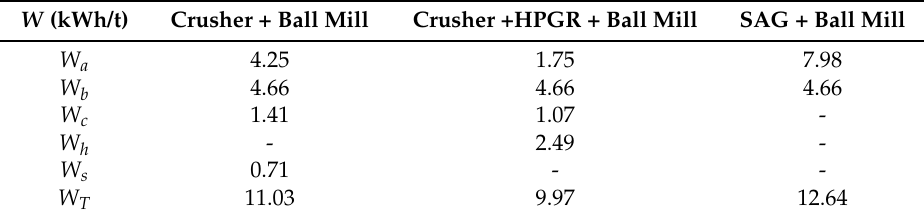
Table 8. Specific energy consumptions of the three combined